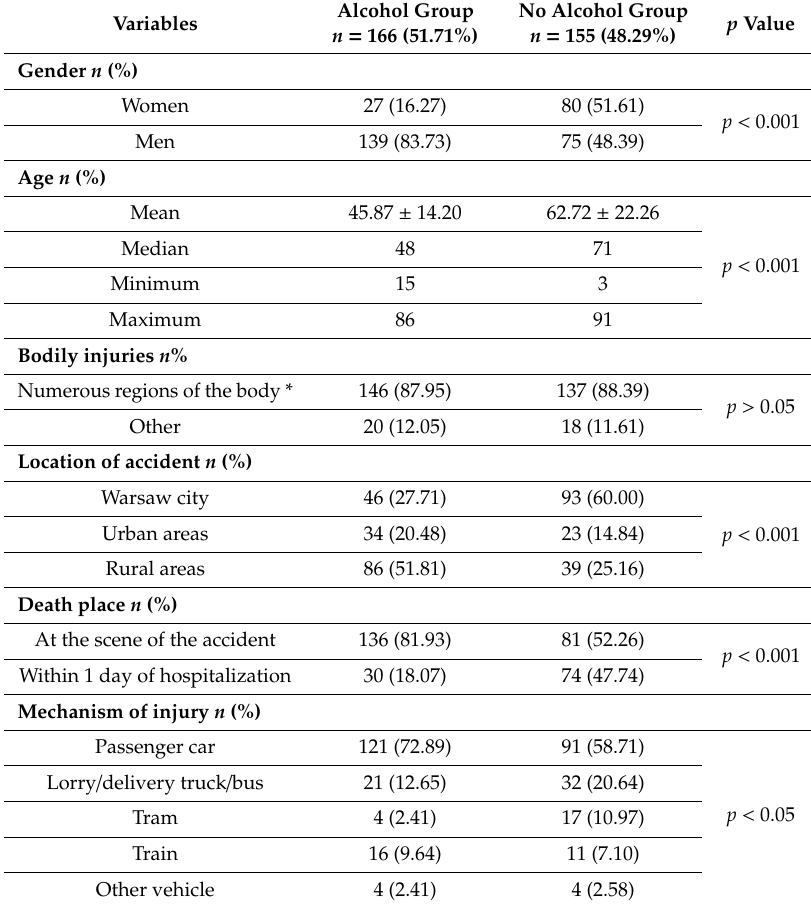
Table 2. Distribution of analyzed